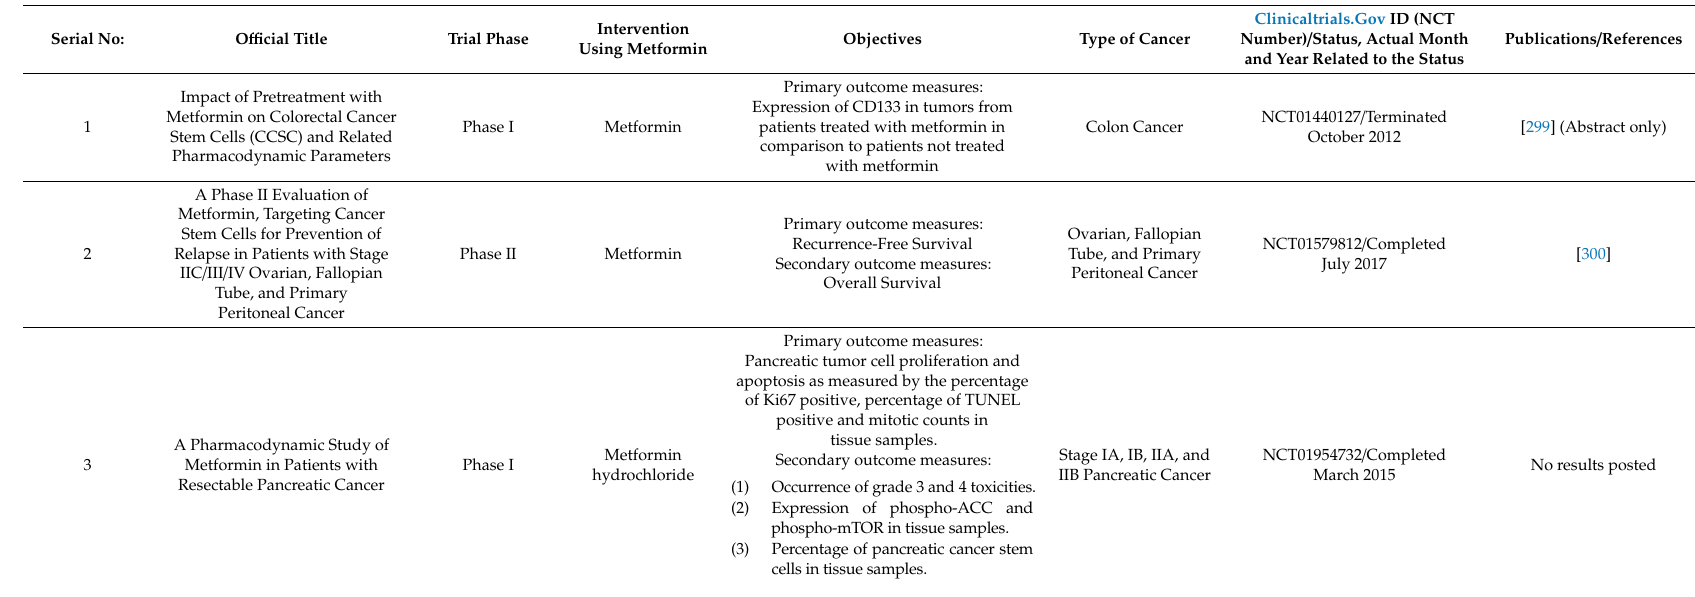
Table 4. Cancer stem cell (CSC)-related clinical trials involving metformin intervention (https: // clinicaltrials.gov /